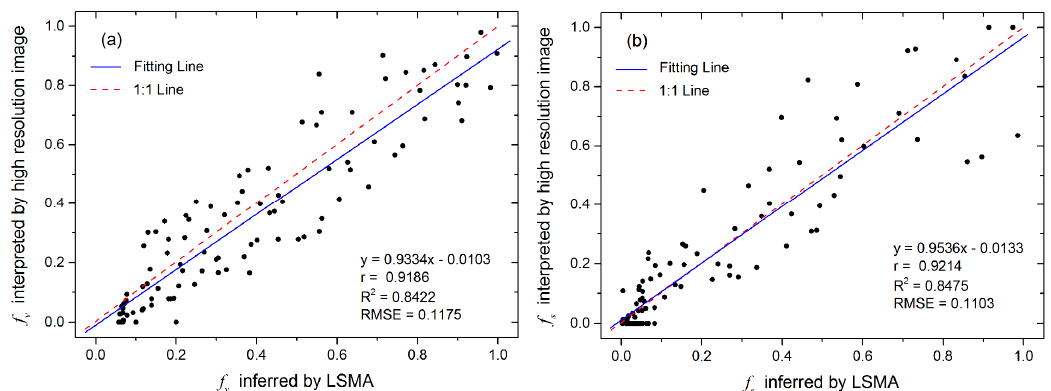
Figure 7. Scatter plots of LSMA modeled surface component fractions against those extracted from Google Earth image: ( a ) vegetation fraction; ( b ) soil fraction.